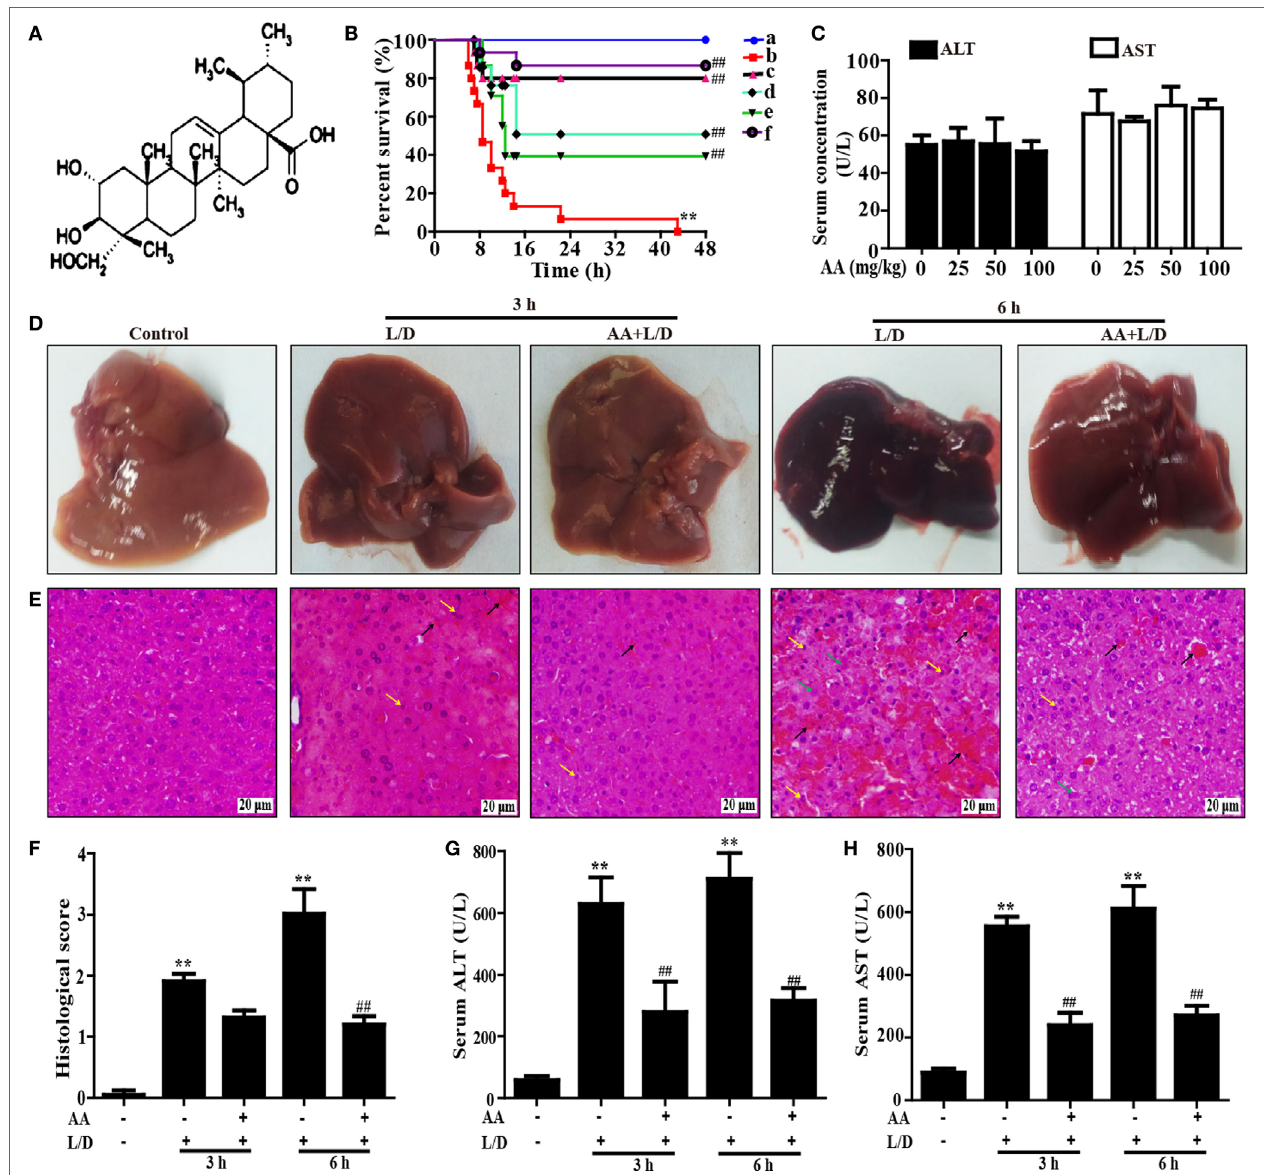
FigUre 1 | Protective effect of AA treatment on lipopolysaccharide (LPS)/ d -galactosamine (GalN)-induced fulminant hepatic failure. (a) The chemical structure of asiatic acid (AA). (B) AA (6.25, 12.5, or 25 mg/kg) or hemin (30 mg/kg) was administered intraperitoneally to mice for twice at a 12-h (interval for 12 h), followed by subjected treatment with LPS (30 µg/kg) and d -GalN (600 mg/kg), which is abbreviated as L/D. The survival rates of the mice were observed within 48 h after L/D exposure. (a) Control and AA group; (b) L/D group; (c) AA (25 mg/kg) + L/D; (d) AA (12.5 mg/kg) + L/D; (e) AA (6.25 mg/kg) + L/D; (f) hemin (30 mg/kg) + L/D. (c) Mice only were given an intraperitoneal injection of AA (0, 25, 50, and 100 mg/kg) and we harvested serum for the analysis of alanine transaminase (ALT) and aspartate aminotransferase (AST) levels at 6 h. (D) Livers ( n = 5) from each experimental group were processed for gross examination of liver at 3 or 6 h after the L/D challenge. (e) Representative histological sections of the livers were stained with hematoxylin and eosin (H&E)-stained (magnification 400 × , black arrows: hemorrhage; green arrows: necrotic area; yellow arrows: inflammatory cell infiltration). (F) The stained sections were graded using a four-point scale from 0 to 3, with 0, 1, 2, and 3 representing no damage, mild damage, moderate damage, and severe damage, respectively. Additionally, sera were collected from the mice after exposure to L/D for 3 and 6 h for measurement of the ALT and AST levels. (g,h) Effects of AA on the serum ALT and AST levels. Similar results were obtained from three independent experiments. All data are presented as means ± SEM ( n = 5 in each group). * p < 0.05 and ** p < 0.01 vs. control group; # p < 0.05 and ## p < 0.01 vs. L/D